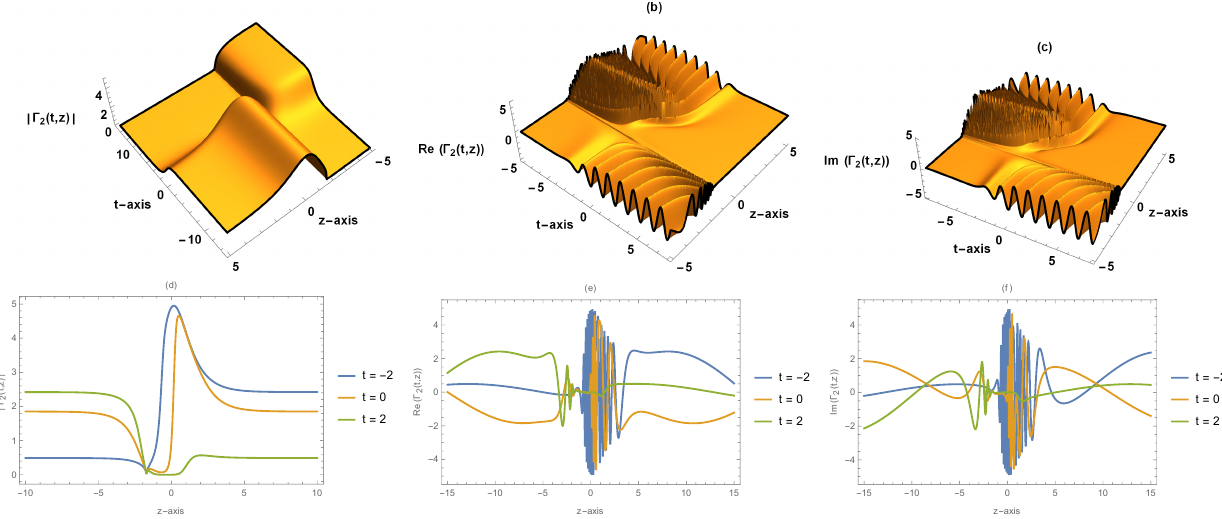
Figure 2. ( a , d ) Absolute value of Γ 2 ( t , z ) . ( b , e ) Real part of Γ 2 ( t , z ) . ( c , f ) Imaginary part of Γ 2 ( t , z ) . The complex bright-dark solitary wave solution Γ 2 ( t , z ) given by (20) in 3D and 2D plots for ρ 0 ( z ) = 1, ρ 1 ( z ) = sech ( z ) , ρ 2 ( z ) = − 1/4, ¯ h 0 ( z ) = tanh ( z ) , ¯ h 1 ( z ) = 1, q ( z ) = − 2sech 2 ( z ) , κ = − 1/2, θ =